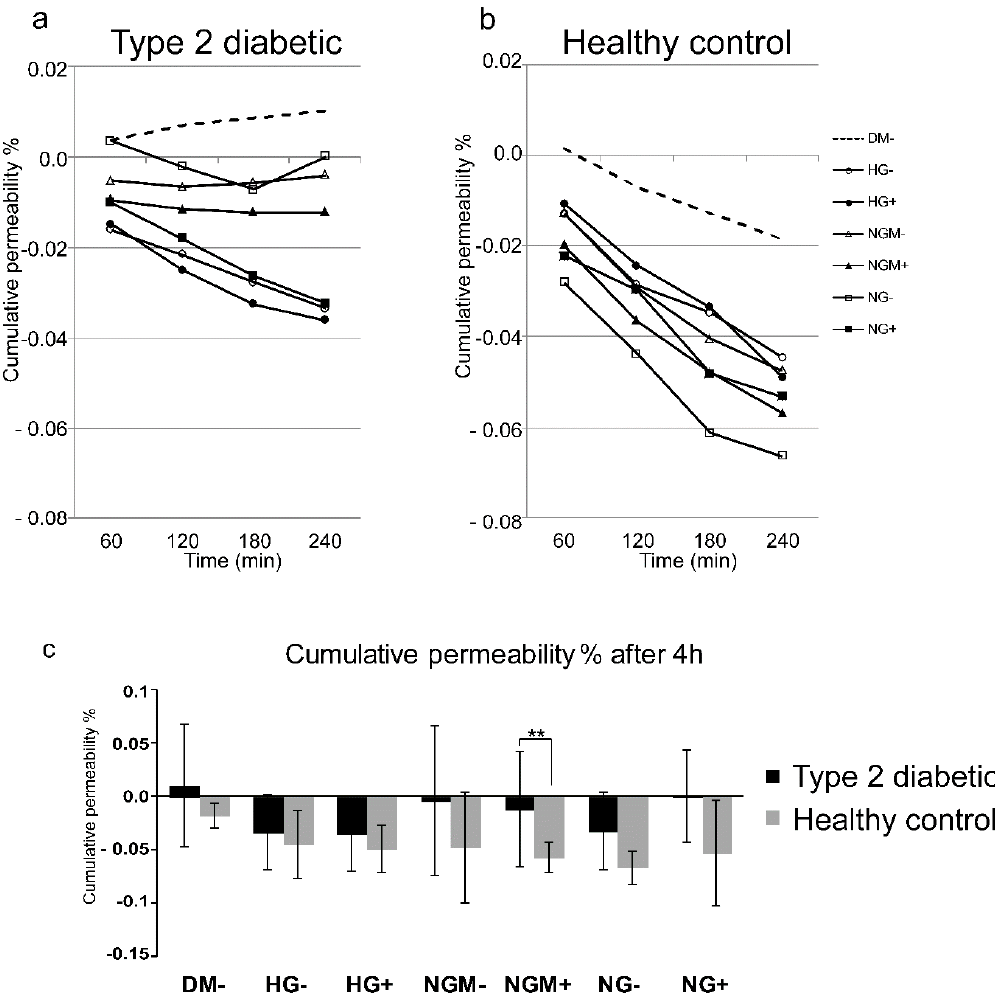
Figure 5. Cumulative permeability in diabetic and healthy control hiPSC-RPEs. After the 5-week culture, the hiPSC-RPEs were subjected to permeability analysis ( a – c ). The cumulative transport percentage of 4 kDa Fitc dextran (FD4) from the apical to basal side of hiPSC-RPE in an Ussing chamber system over 240 min in ( a ) type 2 diabetic, and ( b ) healthy control cells. The endpoint measurement of cumulative transport percentage at the 240 min time point is shown in separate graphs presented in ( c ). Data are presented as mean ± SD. Statistical significance p < 0.01 marked as **. HG represents high glucose (25 mM); NG represents normal glucose (5 mM); NGM represents normal glucose (5 mM) balanced with mannitol (19.5 mM). All conditions had +/ − added insulin. DM − is the control culture medium, which is ordinarily used for hiPSC maturation.